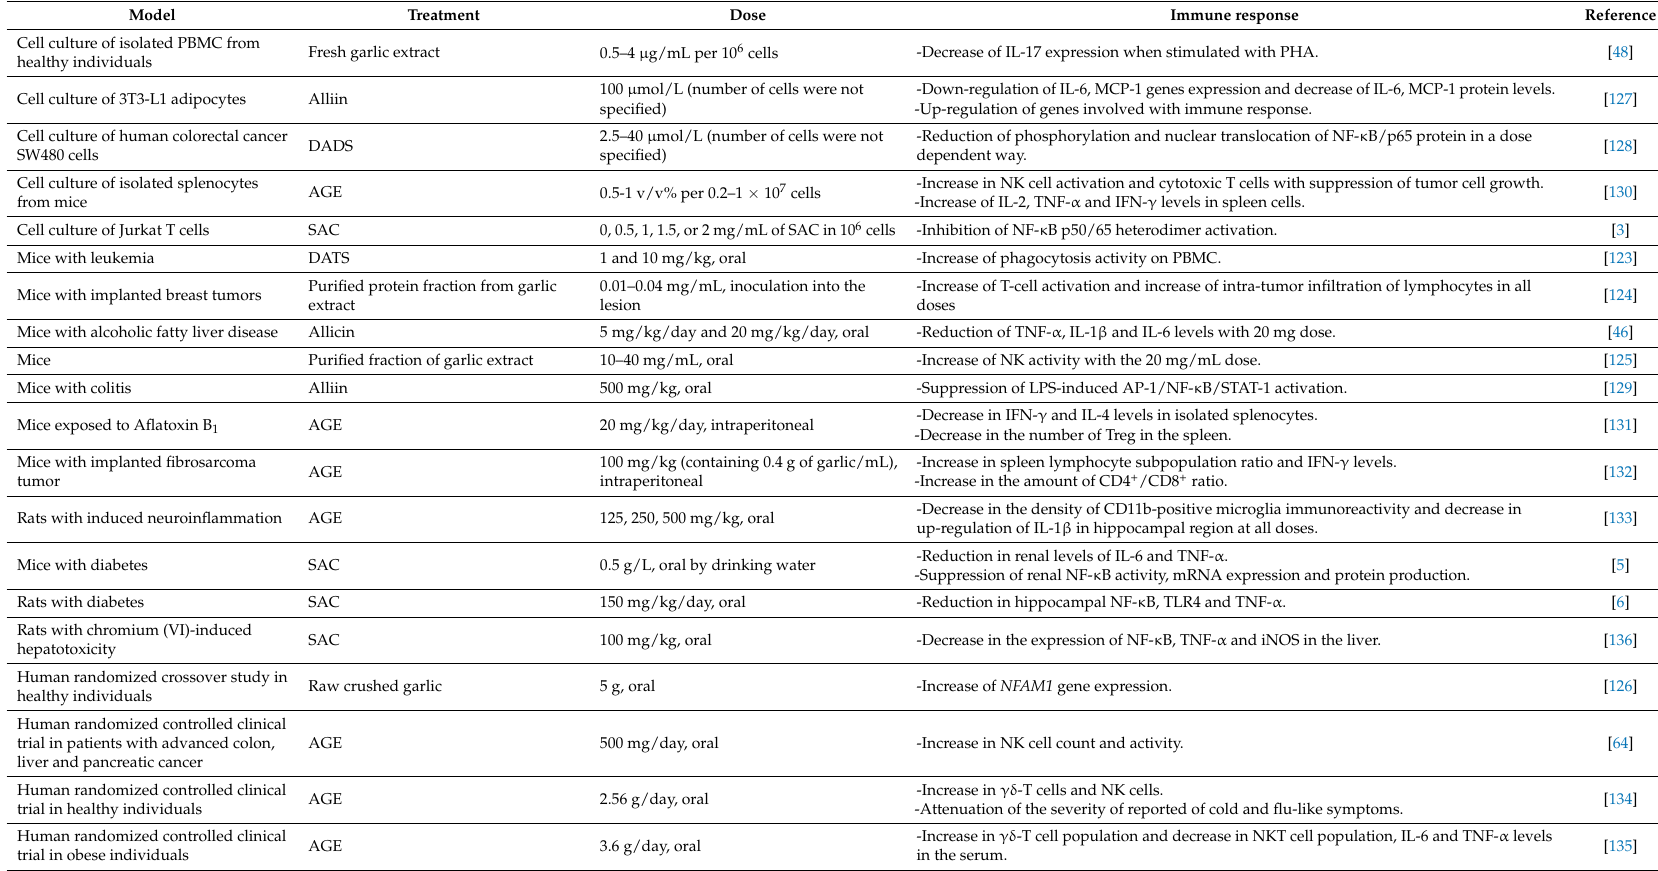
Table 2. Previous studies on the effect of garlic derivatives in the immune